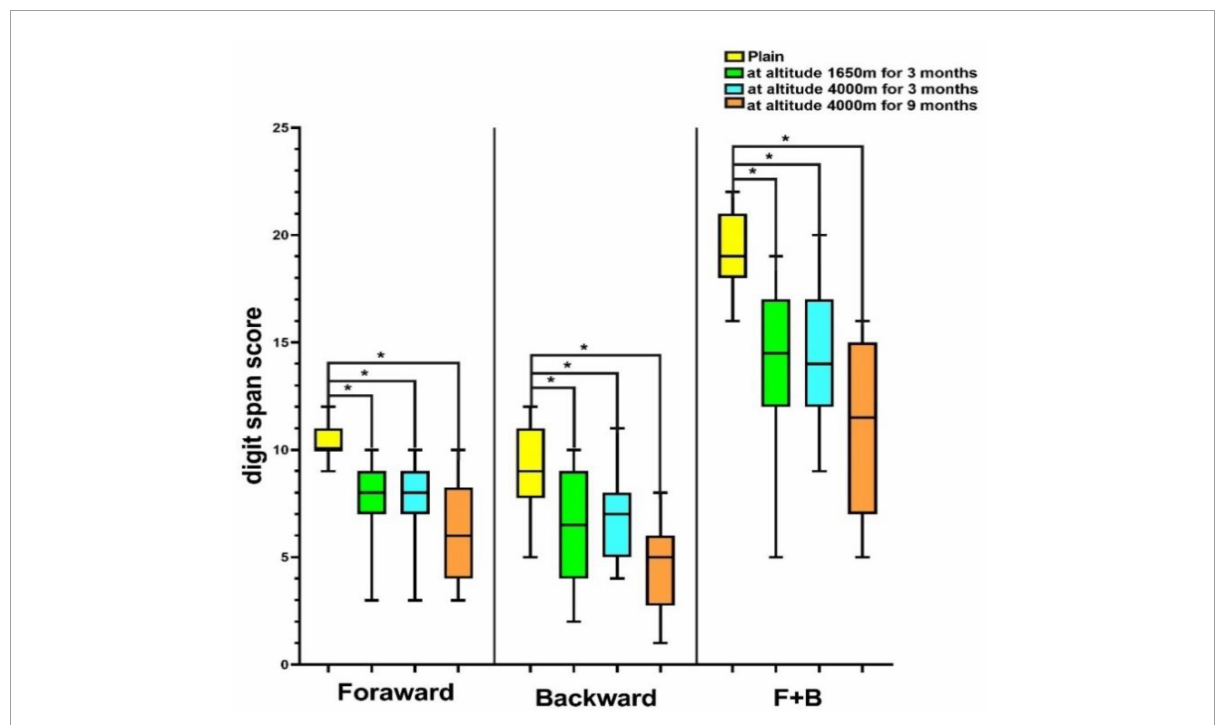
FIGURE3 Digit span score of volunteers at different altitudes. * P < 0.05. F+B, forward+backward